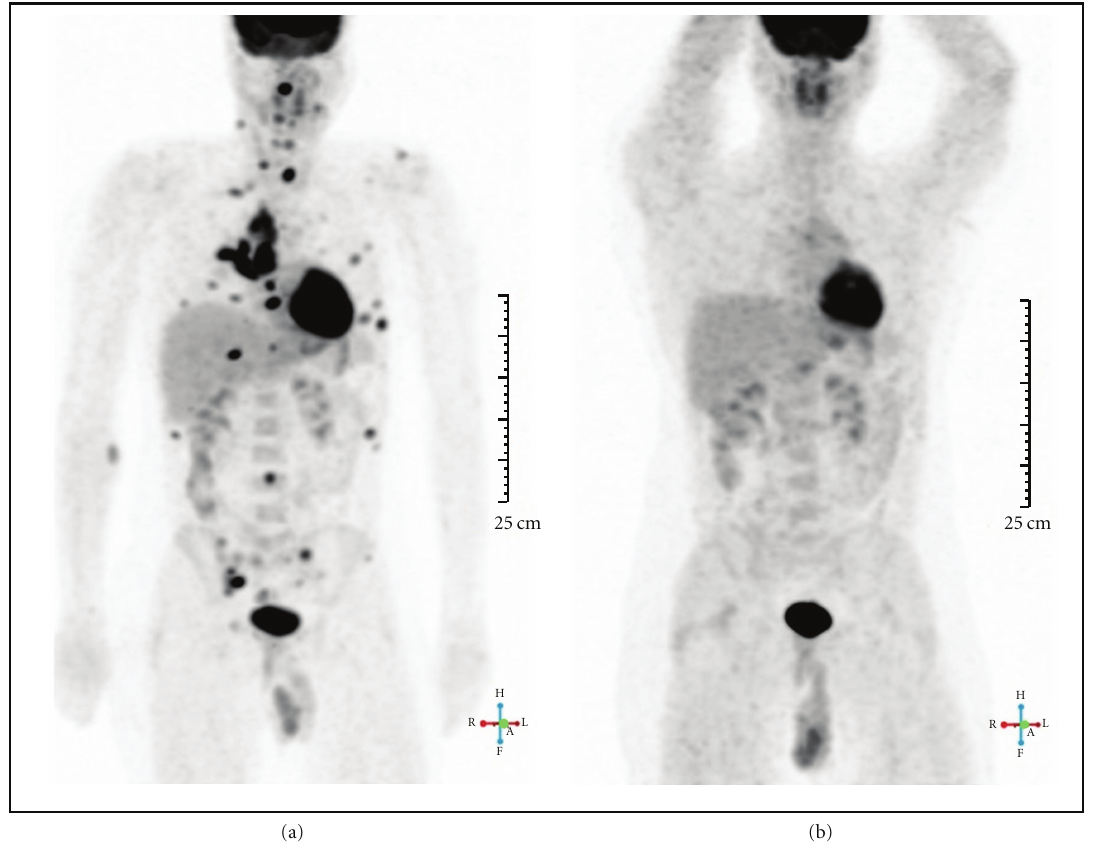
Figure 2: (a) represents 18 F-FDG-PET/CT imaging showing multifocal hypermetabolic lesions of the sacroiliac joints, lungs and axillary, cervical, supraclavicular lymphadenopathy suggestive of systemic disease. (b) represents 18 F-FDG-PET/CT imaging one year after anti- tuberculosis treatment. All hypermetabolic lesions have been cleared, confirming e ffi cient therapy of tuberculosis. Myocardial infarction was ruled out, and the patient was treated with NSAIDs with good clinical